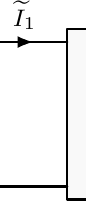
Figure 2. General one-port